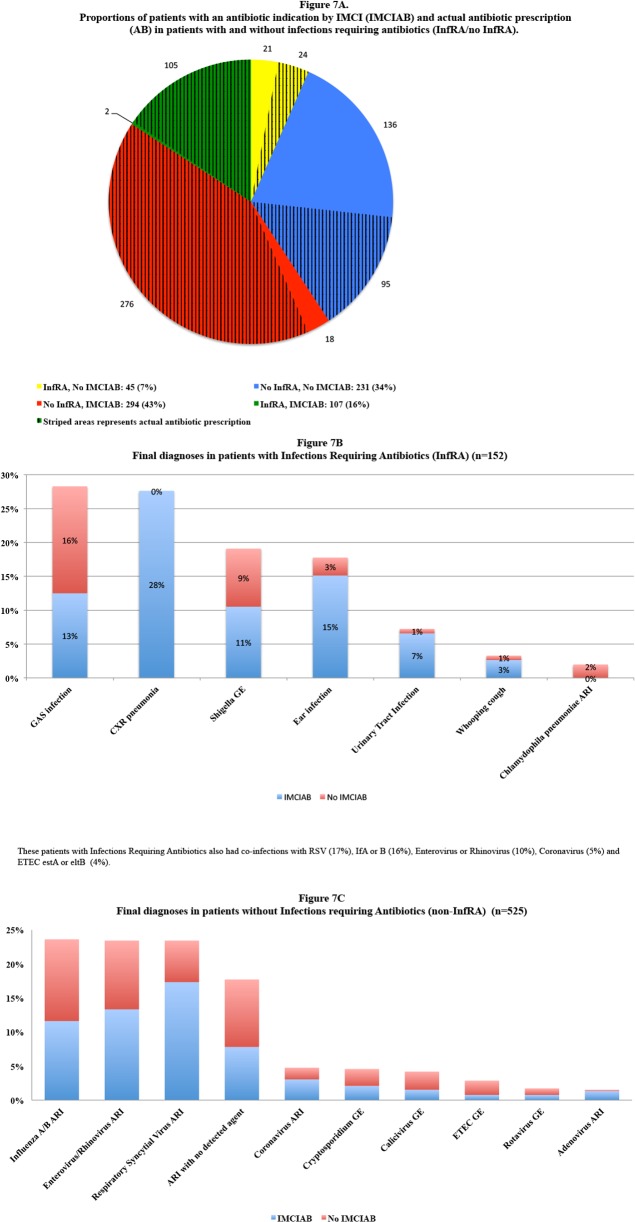
A: Proportions of patients with an antibiotic indication by IMCI (IMCIAB) and actual antibiotic prescription (AB) in patients with and without infections requiring antibiotics (InfRA/no InfRA). B: Final diagnoses in patients with Infections Requiring Antibiotics (InfRA). C: Final diagnoses in patients without Infections Requiring Antibiotics (non-InfRA).